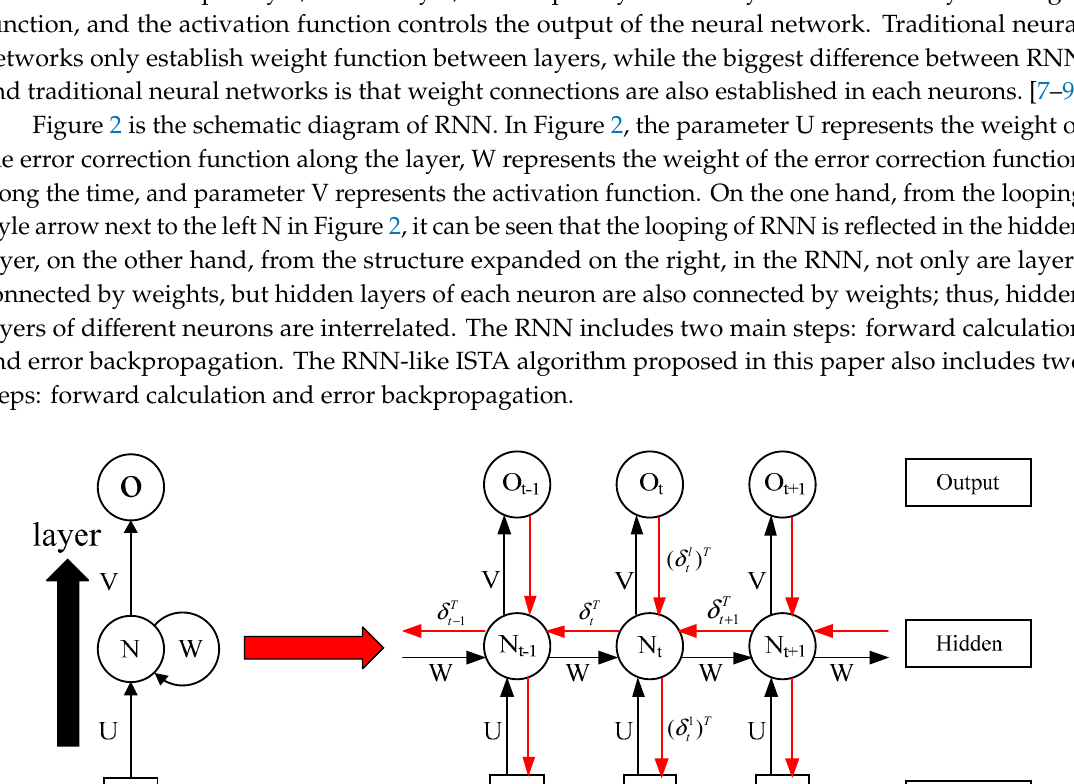
Figure 3. RNN-like ISTA flow charts.